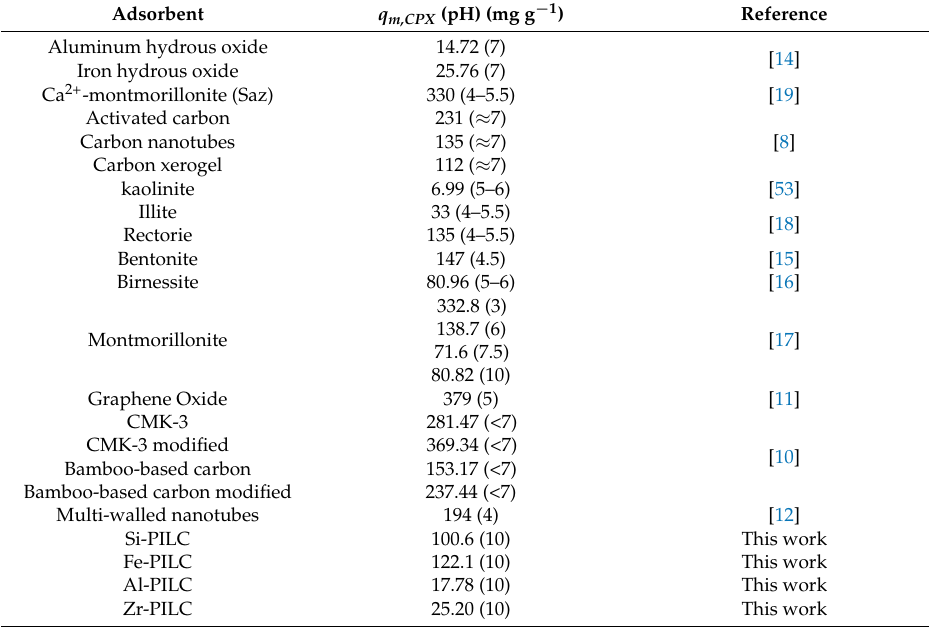
Table 4. CPX adsorption capacities for different